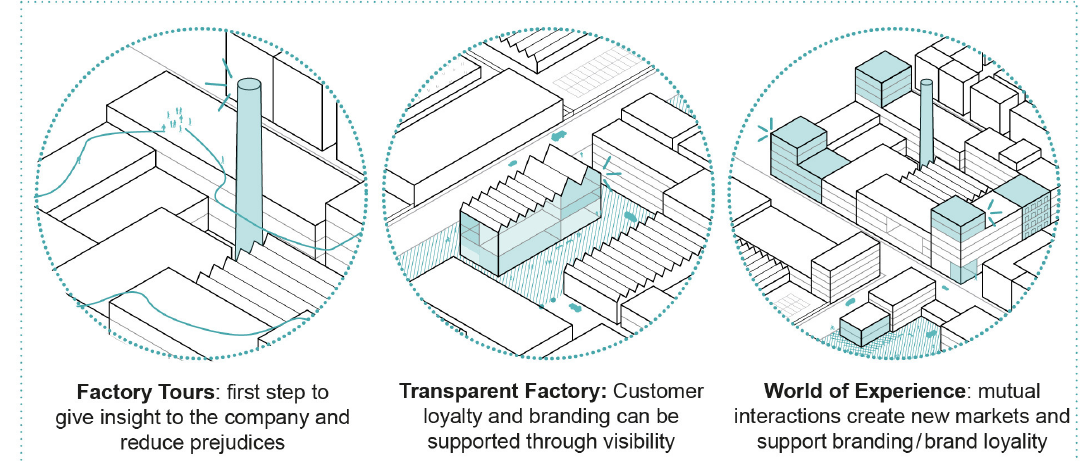
Figure 4. “Experience Factory” (potential to connect is marked in green; see description in Subsection 3.4). small‐scale qualification of public spaces and the cre‐ ation of new jobs and new markets to buildings that shape the